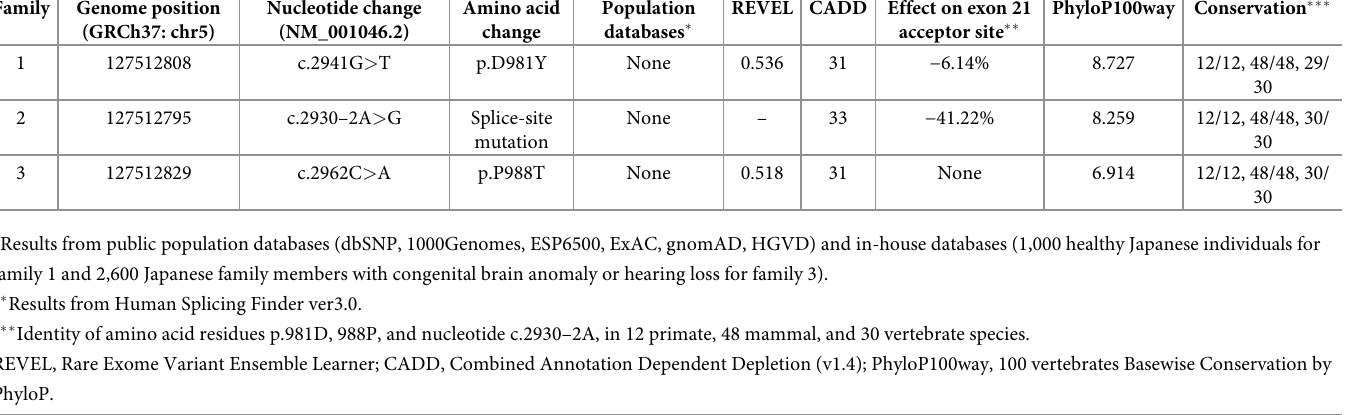
Table 1. SLC12A2 variants detected in this study. Family Genome position (GRCh37: